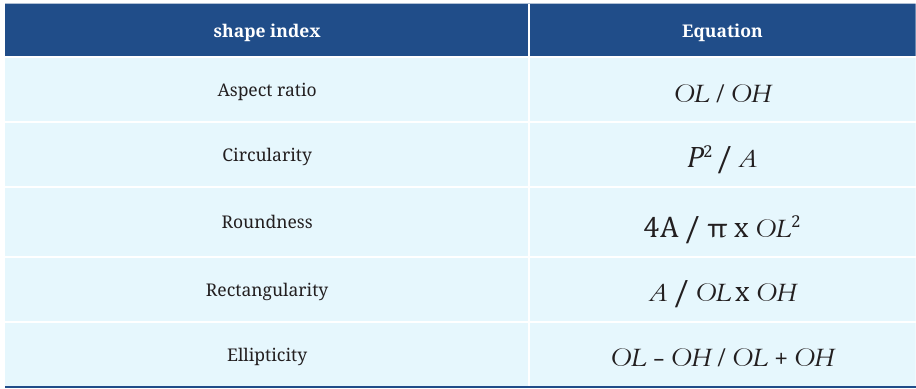
TABLE 1 | Equations used to estimate the shape indices of the otoliths. OL = otolith length, OH = otolith height, P = perimeter, and A =